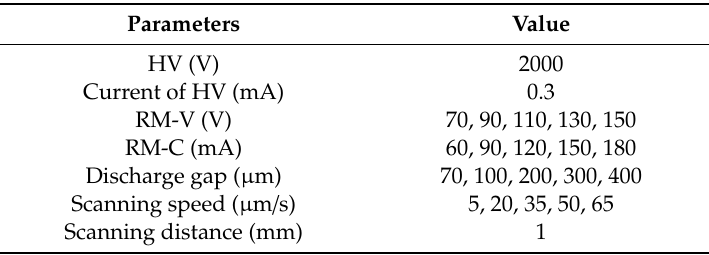
Table 4. HV- µ EAM